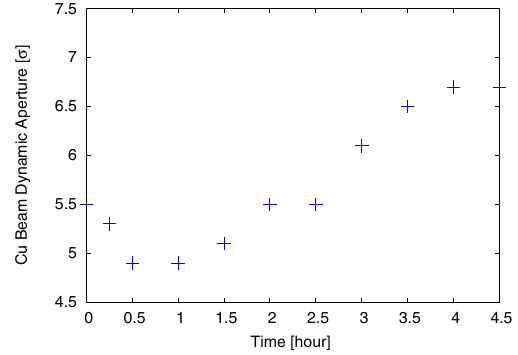
FIG. 14. Calculated dynamic aperture for the Cu beam with full gains of 3-d stochastic cooling. Bunch intensities and emittances were taken from the fill shown in Fig. 13. The initial particle ’ s relative momentum deviation is 1 . 5 × 10 − 5 .